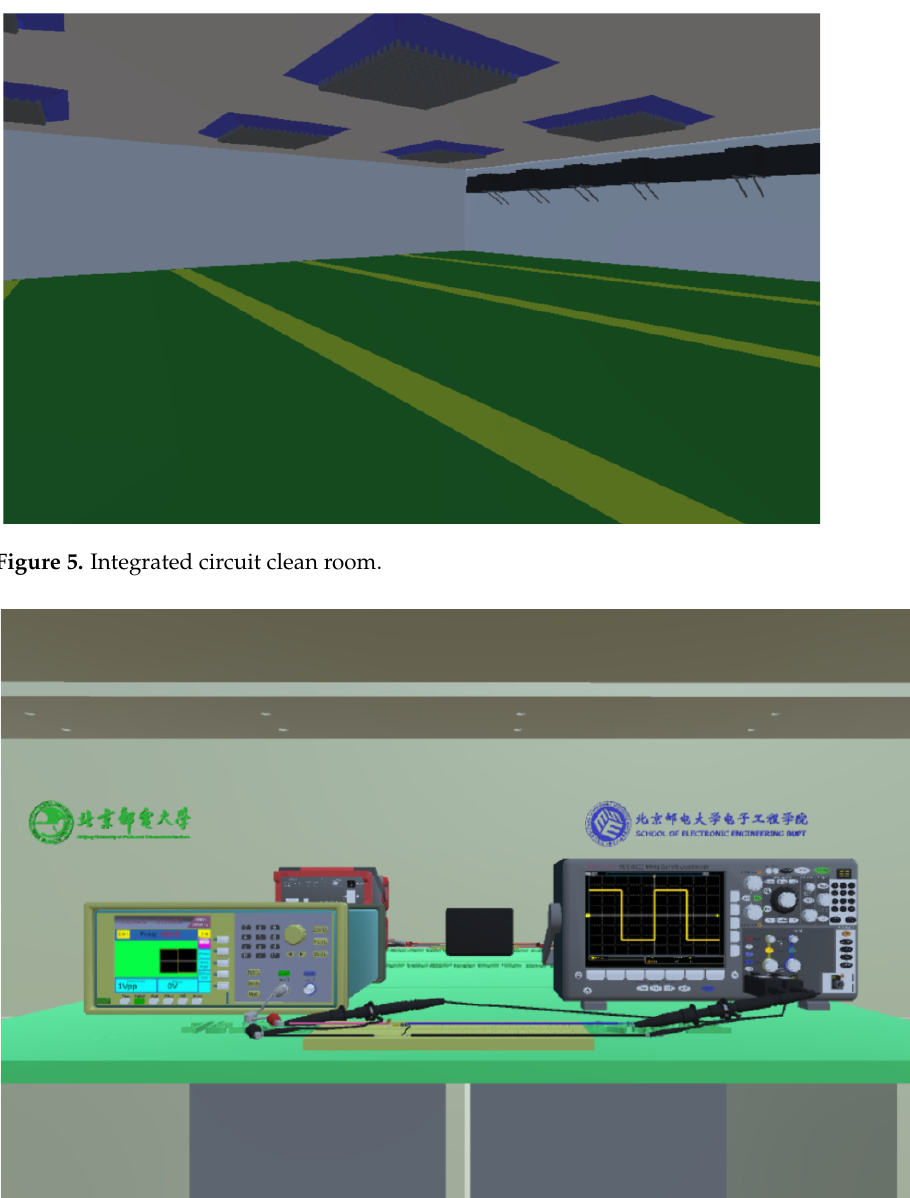
Figure 4. Production process of laboratory 3D scene.